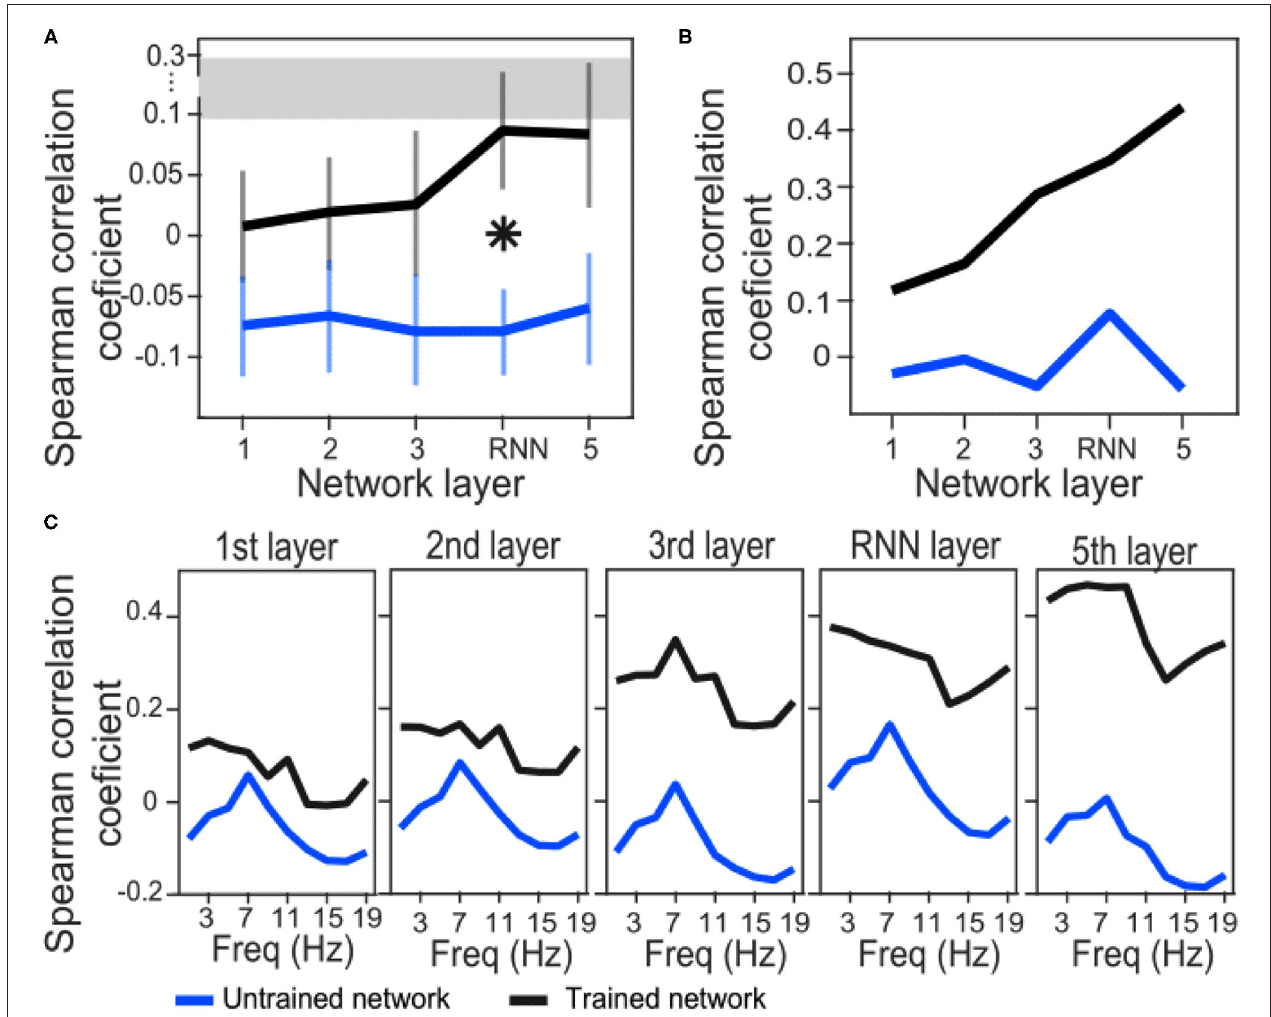
FIGURE 4 | Correlation coefficients between brain and network RDMs. (A) Correlation coefficients between EEG RDMs of each participant and the trained/untrained network RDMs of each layer, averaged across the participants. For the untrained networks, correlation coefficients were first averaged across the 100 shuffles and then grand averaged across the participants. The error bars indicate SEM. Asterisk indicate statistically significant differences between trained and untrained networks in the specified layer ( t -test, p < 0.05). The gray bar displays the noise ceiling with a lower bound of 0.094 and an upper bound of 0.295. (B) Correlation coefficients between averaged EEG RDMs across the participants and the trained/untrained network RDMs of each layer (only one untrained network is shown here for illustration). (C) EEG signals were first filtered in each 2Hz frequency bands and then RDMs were calculated. Correlation coefficients between averaged EEG RDMs across the participants and the trained/untrained network RDMs of each layer are plotted (only one untrained network is shown for